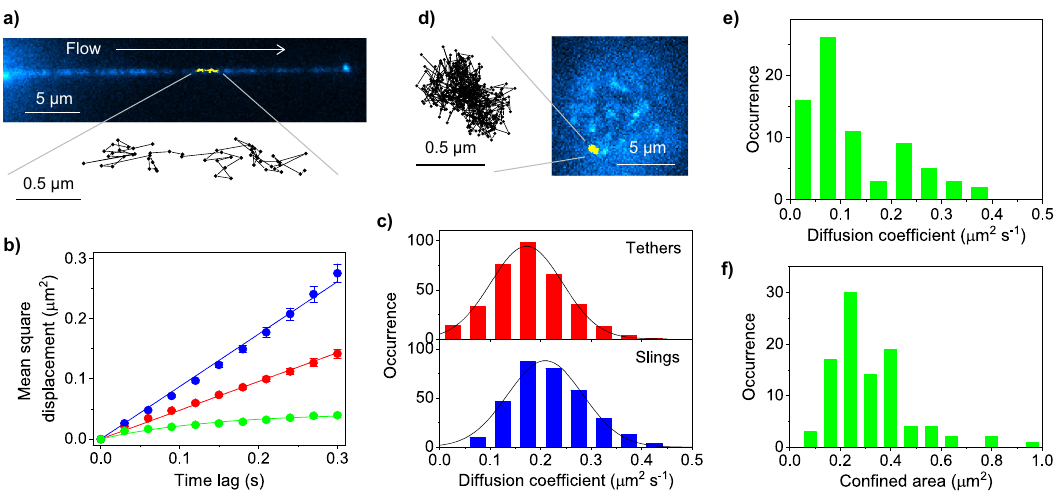
Fig. 7 Single-molecule tracking analysis of PSGL-1 on the tethers and slings. a Single-molecule fl uorescence images of PSGL-1 (immunostained by Alexa- Fluor-555-conjugated anti-PSGL-1 antibody) on the sling of the KG1a cell formed during cell rolling over E-selectin at a shear stress of 2 dyne cm − 2 (0.2 Pa). An example of the single-molecule diffusion trajectories obtained from the time-lapse fl uorescence images is shown by the yellow line. b Mean square displacement (MSD) versus time lag plots obtained for the PSGL-1 molecules diffusing on the tethers (red), slings (blue), and localized on the microvilli of the control KG1a cells (green). The error bars show the standard errors of the mean determined by 340, 320, and 129 MSD plots obtained for the PSGL-1 molecules diffusing on the tethers, slings, and localized on the microvilli of the control KG1a cells. c Frequency histograms of the diffusion coef fi cient of the PSGL-1 molecules on the tethers (top) and slings (bottom) of the KG1a cells formed during cell rolling over E-selectin at a shear stress of 2 dyne cm − 2 (0.2 Pa). The diffusion coef fi cients were calculated by fi tting the MSD plots obtained from the individual diffusion trajectories to Eq. 4. The solid lines show Gaussian fi ttings. d Single-molecule fl uorescence images of PSGL-1 (immunostained by Alexa-Fluor-488-conjugated anti-PSGL-1 antibody) on the microvilli of the control KG1a cell. An example of the single-molecule diffusion trajectories obtained from the time-lapse fl uorescence images is shown in the yellow line. e Frequency histogram of the diffusion coef fi cient of the PSGL-1 molecules on the microvilli of the control KG1a cells. The diffusion coef fi cients were calculated by fi tting the MSD plots obtained from the individual diffusion trajectories to Eq. 5. f Frequency histogram of the con fi ned area of the diffusing PSGL-1 molecules on the microvilli of the control KG1a cells. The con fi ned areas were calculated by fi tting the MSD plots obtained from the individual diffusion trajectories to Eq. 5. All the fl uorescence images of the rolling cells were captured by injecting KG1a cells into the rh E-selectin- deposited micro fl uidic chambers at a shear stress of 2 dyne cm − 2 (0.2